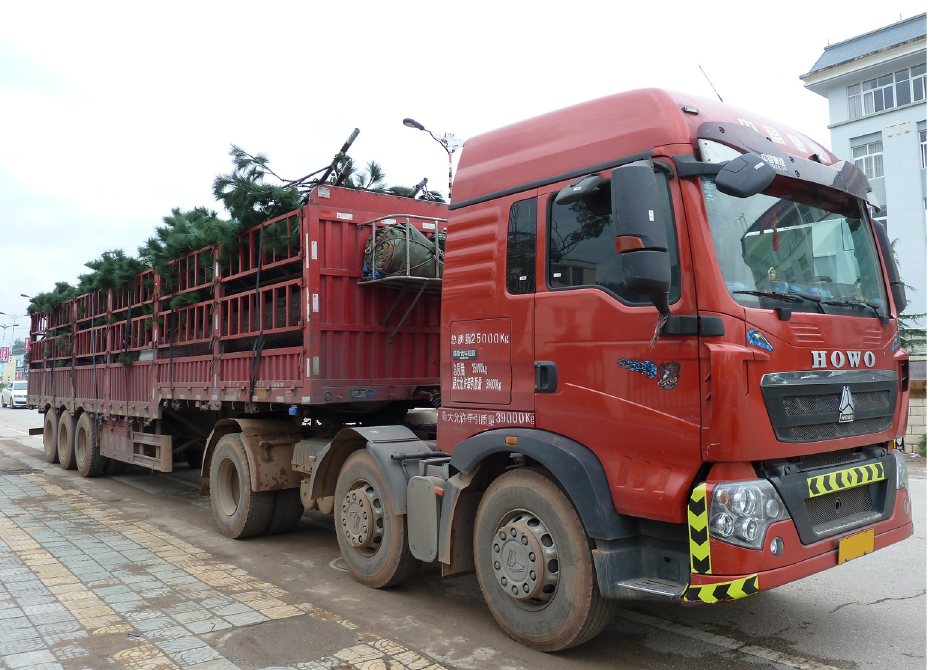
Figure 2. A large trailer truck in Niplat filled with trees ready to be transported for sale, 2015. The fate of this lumber haul, shown here in front of the county courthouse, is unknown. Photograph by the author.